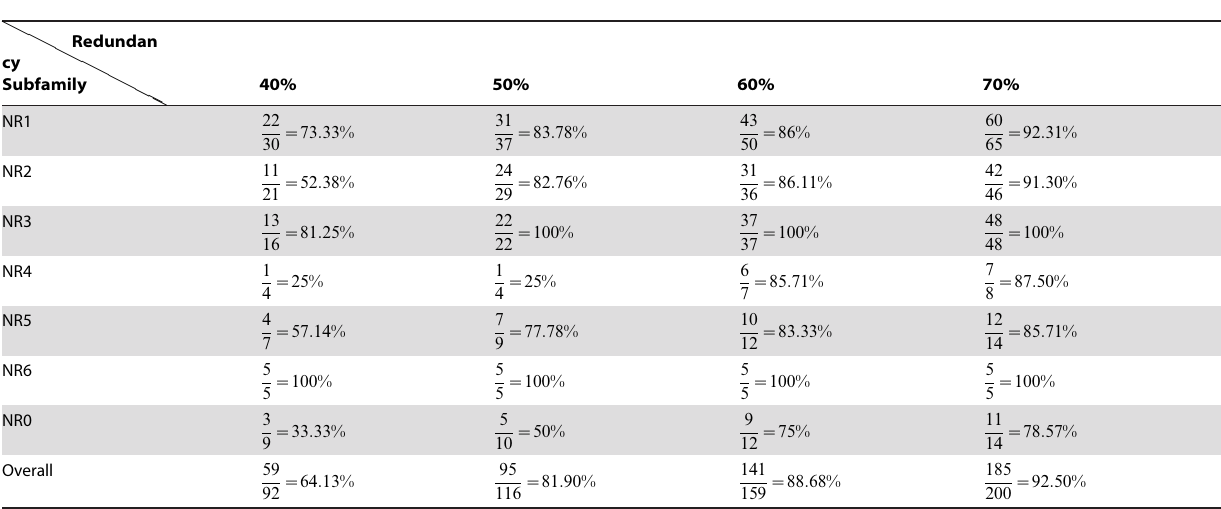
Table 5 . The jackknifing success rates obtained in identifying NR subfamilies with different redundancy reduction cutoff thresholds a .